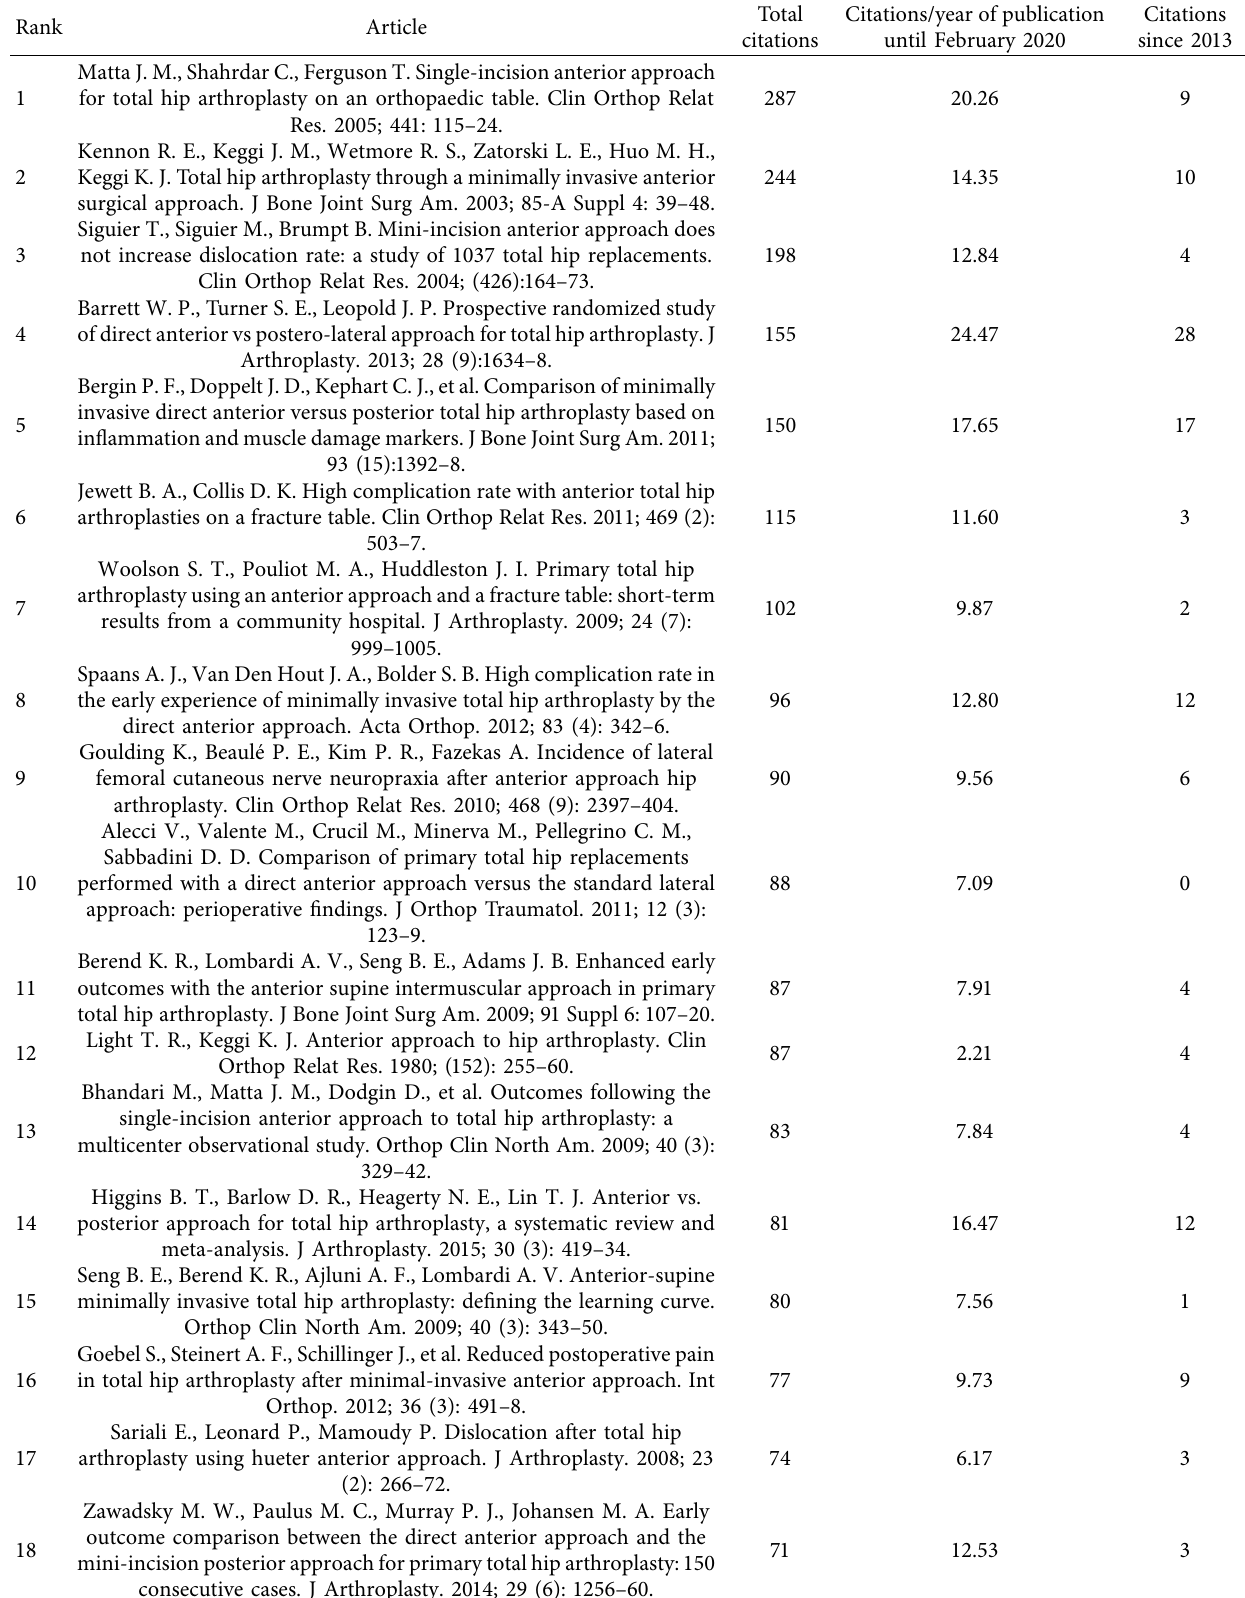
Table 1: Top 50 most cited articles regarding